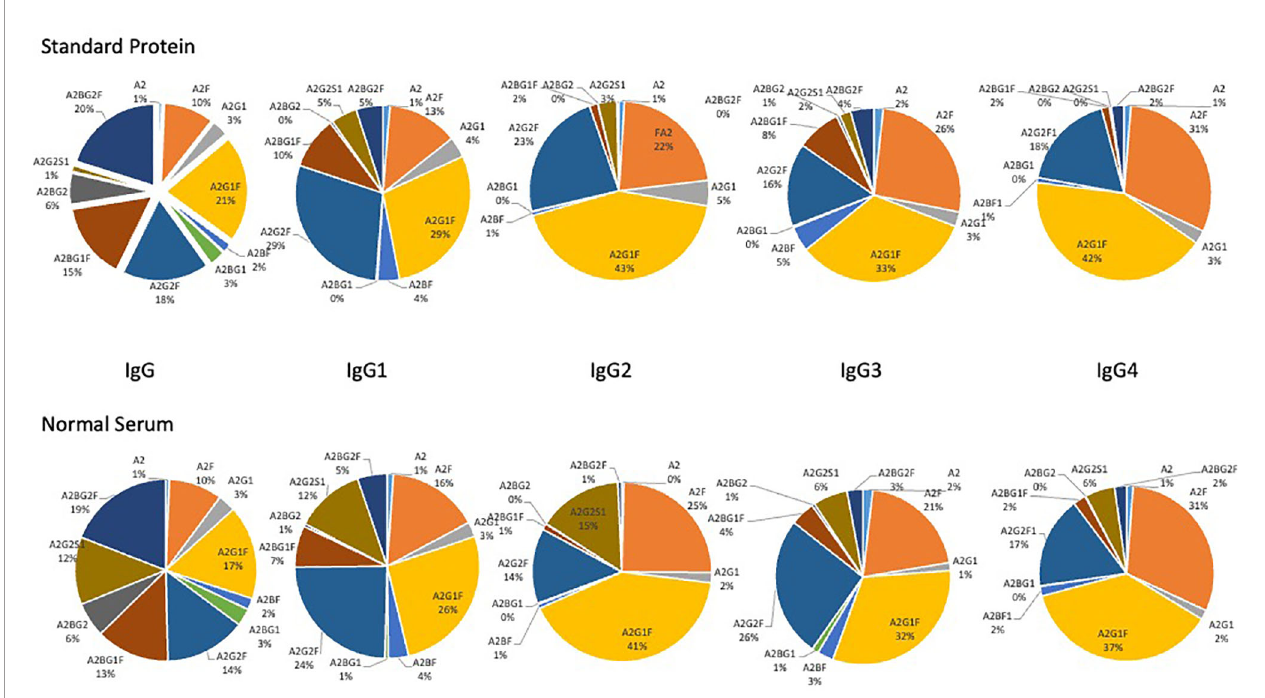
FIGURE 2 | Glycan analysis of antibody captured IgG, IgG1, IgG2, IgG3 and IgG4 from either purchased puri fi ed protein (top) or from normal human serum (bottom). Glycans are presented as a function of the total glycan pro fi le. For glycans, the Oxford notation is based on building up N-glycan structures and it can be used to denote all glycans (51). All N-glycans have two core GlcNAcs and three mannose residues that make up the trimannosyl core; F indicates a core fucose; Ax, where x- number of antenna (GlcNAc) on the trimannosyl core; Gx, where x- number of linked galactose on antenna; Sx, where x- number of sialic acids linked to